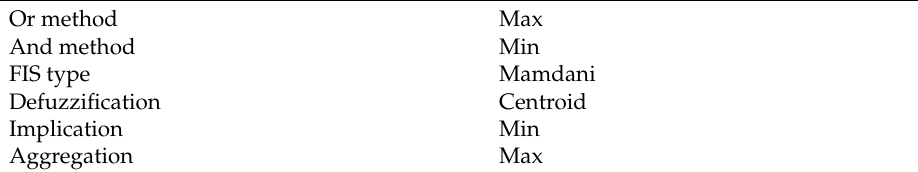
Table A3. Parameters of the fuzzy logic controller.